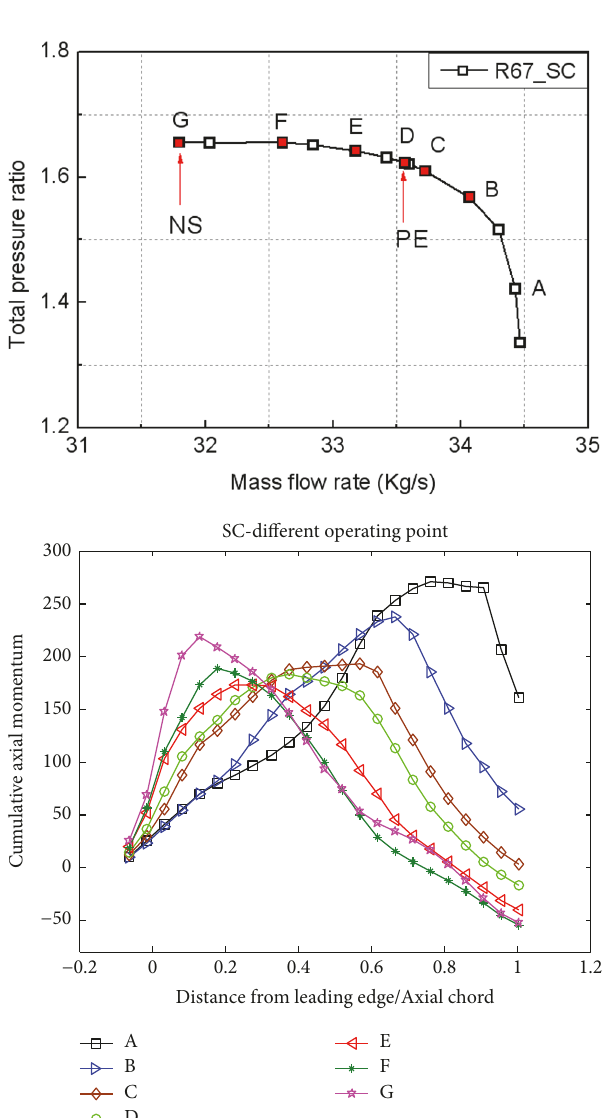
Figure 15: The bell curves during the throttling process of Rotor 67 ([16]). Figure reproduced from NAN et al. (2014).